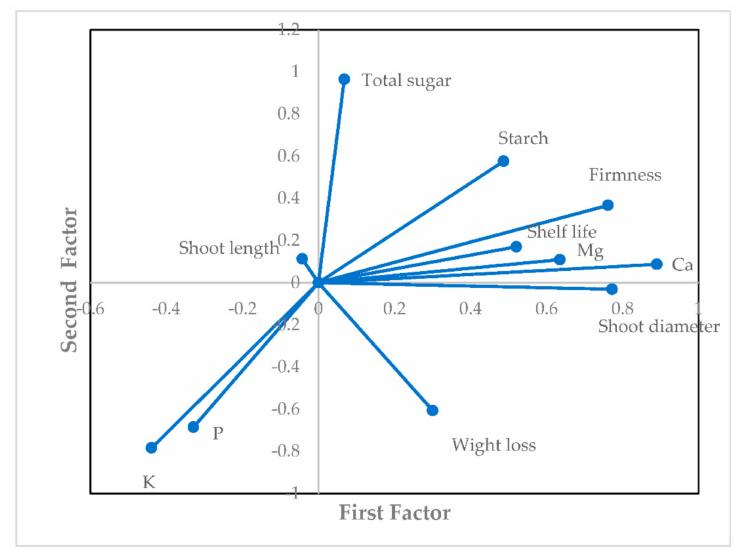
Figure 1. Loading plot for factor